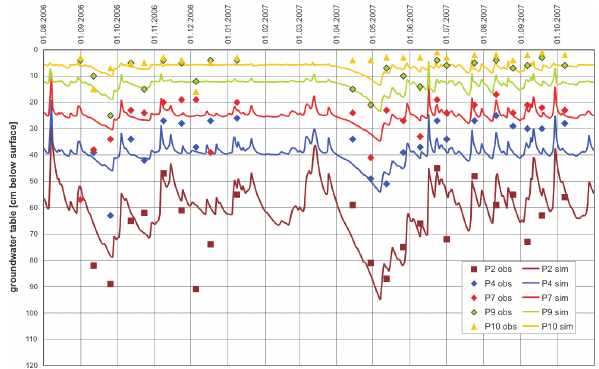
Fig. 5. Measured and calculatetd groundwater levels of observation wells within the peatland “Große